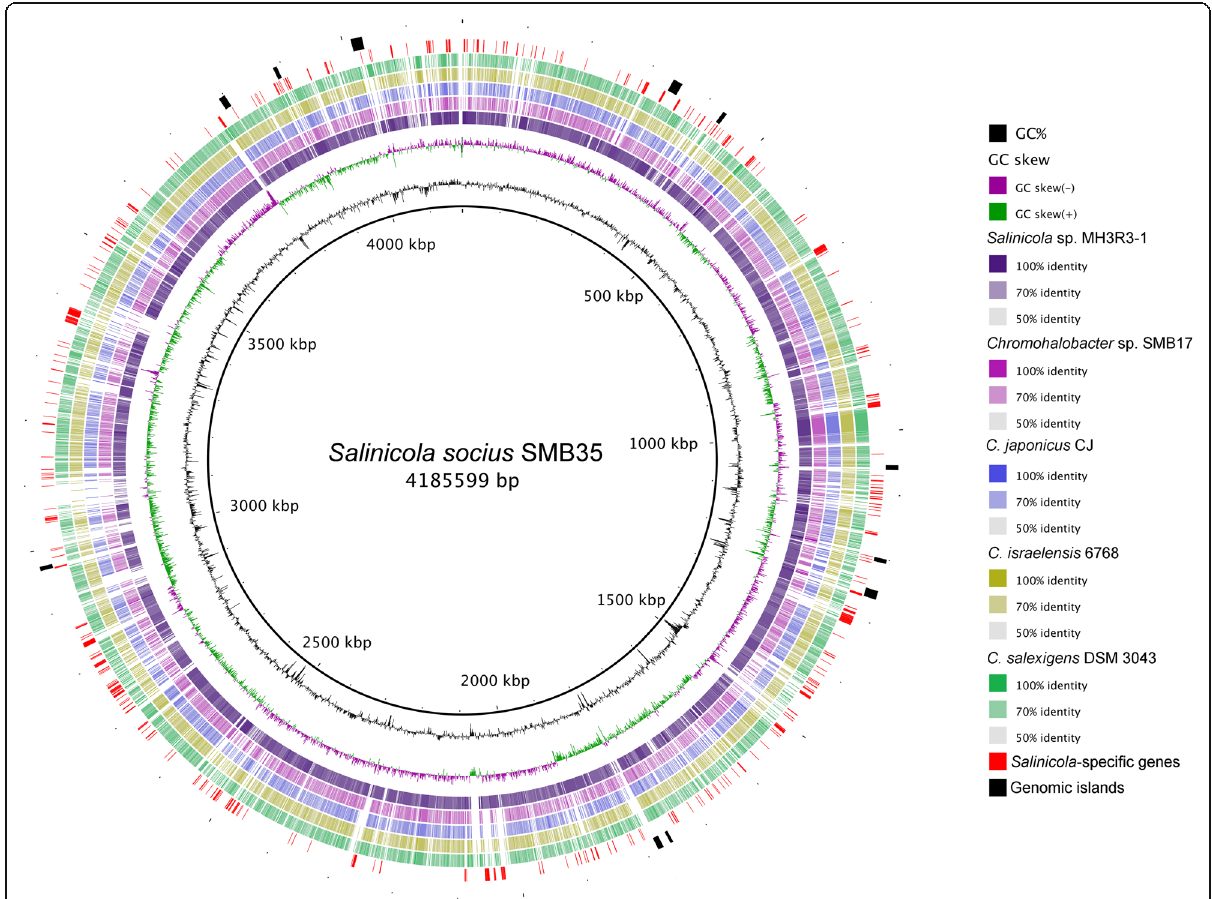
Fig. 3 Circular representation of the S. socius SMB35 T genome and its comparison to genomes of the Salinicola-Chromohalobacter group. Rings from inside to outside: (1) GC content, (2) GC skew, (3) BLASTn comparison with Salinicola sp. MH3R3 – 1, (4) BLASTn comparison with Chromohalobacter sp. SMB17, (5) BLASTn comparison with C. japonicus CJ, (6) BLASTn comparison with C. israelensis 6768, (7) BLASTn comparison with C. salexigens DSM 3043 T , (8) Genome segments present in both Salinicola genomes, but absent from genomes of all Chromohalobacter spp., (9) Genomic islands predicted in the SMB35 T genome. The genome comparisons were visualized using the BRIG software [26]. The inner scales designate the coordinates in kilobase